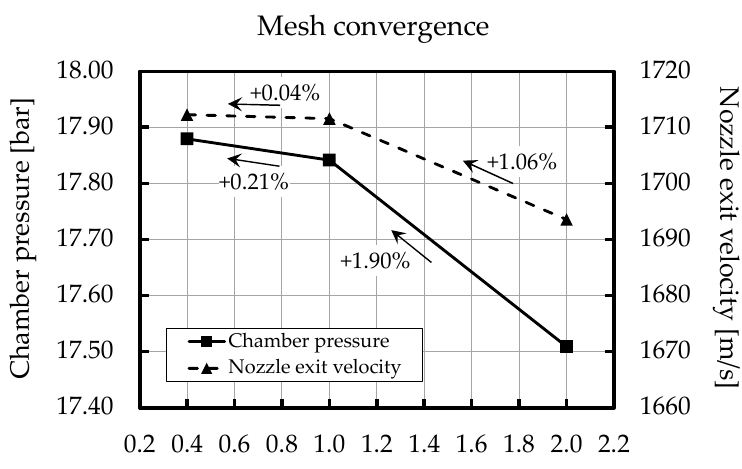
Figure 8. Review of the mesh convergence. Below the characteristic combustion chamber cell size ∆ x char of 1 mm, operating conditions remain quasi